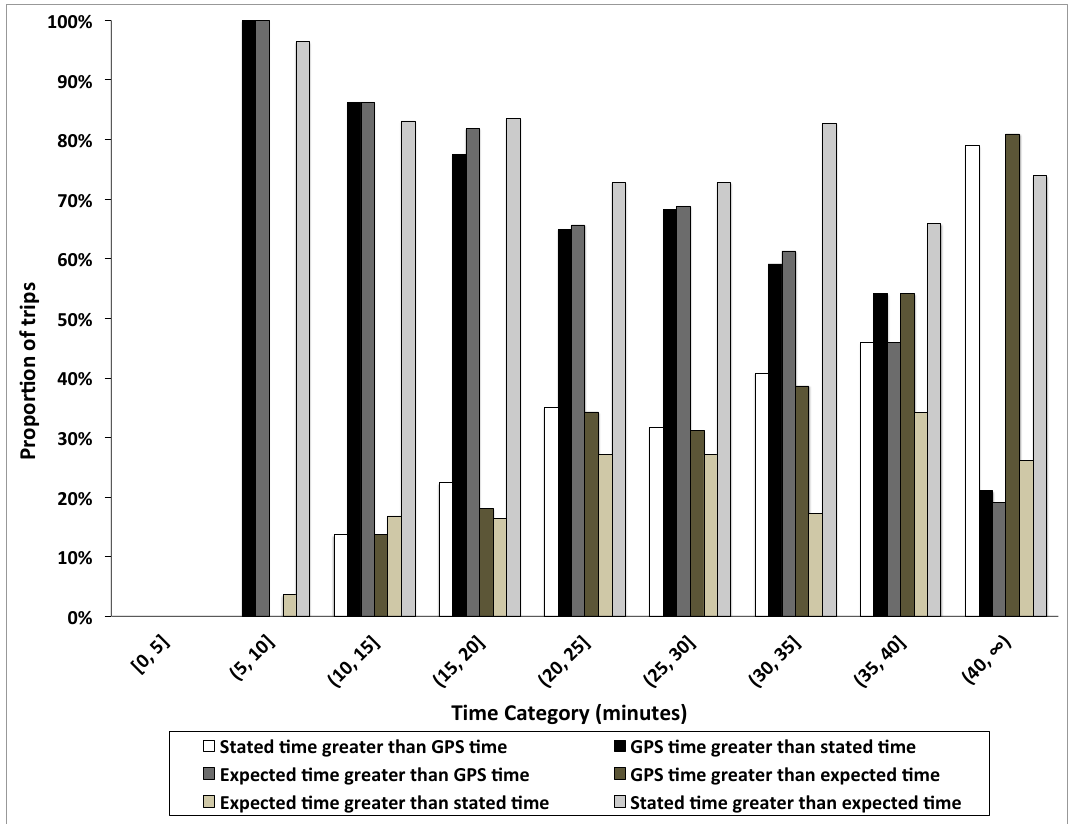
Figure 1. Proportion of trips according to travel time of commute from GPS data and survey data: GPS vs. stated; expected vs. GPS; stated vs.